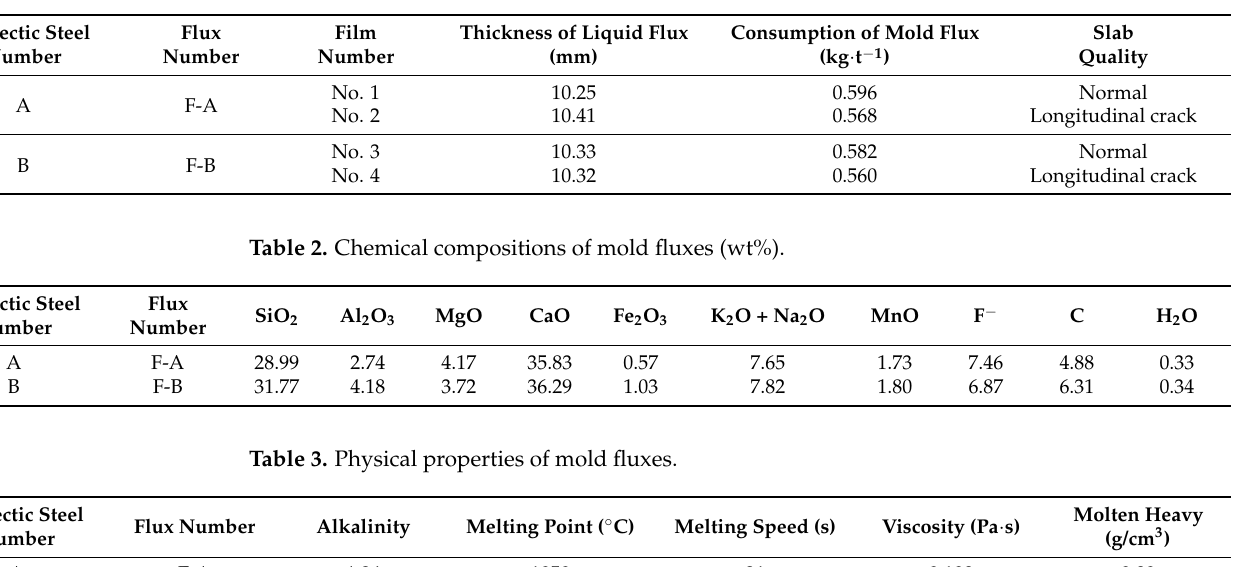
Table 1. Chemical compositions and physical properties of mold fluxes for peritectic steels A and B are listed in Tables 2 and 3. Table 1. Parameters of mold flux films for peritectic steels.